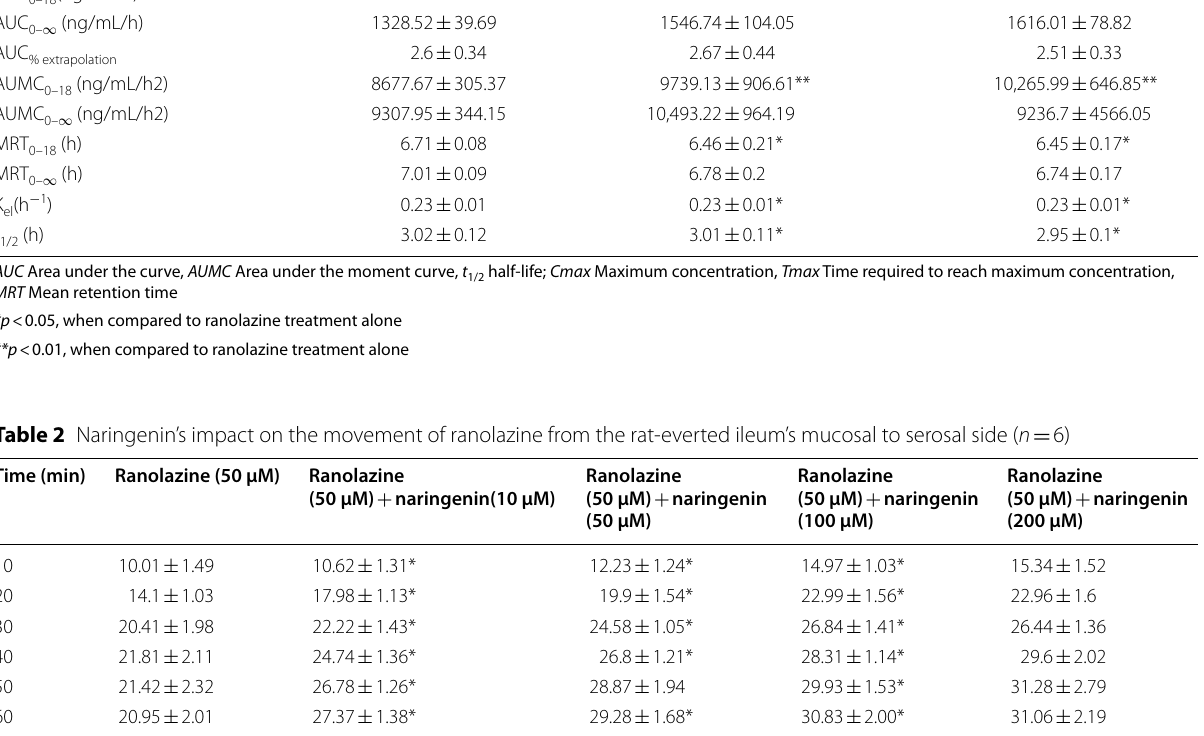
*p < 0.05, when compared to ranolazine treatment alone